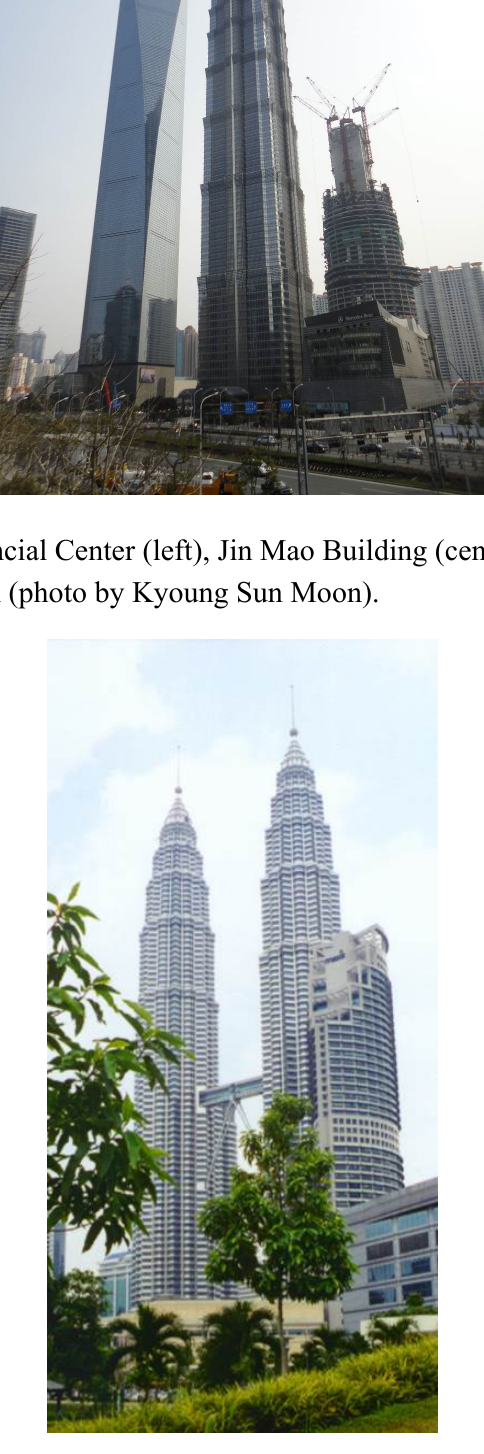
Figure 2. Petronas Towers (courtesy of Abbas